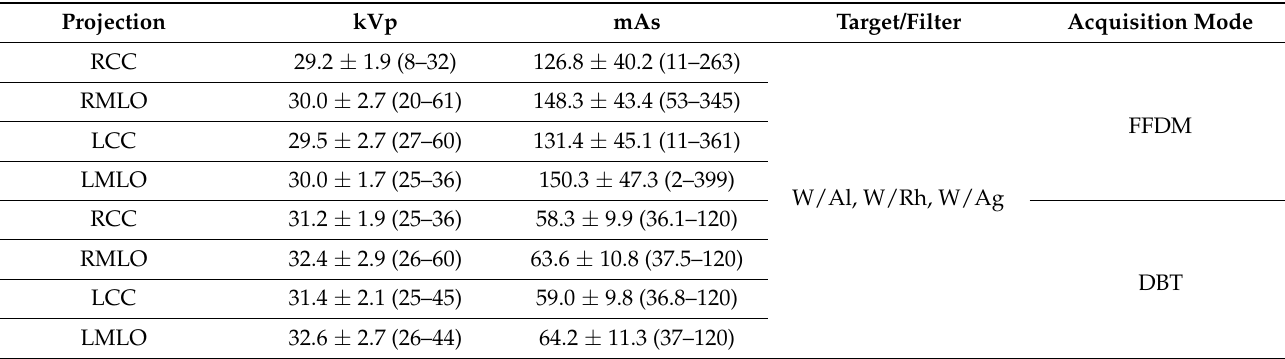
Table 1. Technical exposure factors for each